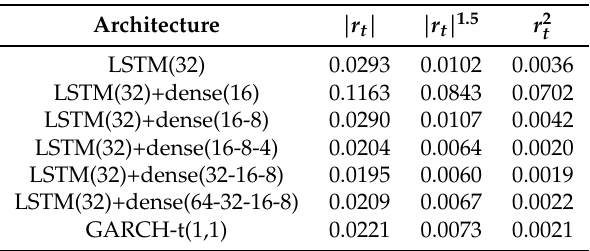
Table 2. Out-of-sample mean absolute errors (MAE) evaluated between 2 March 2018 and 28 February 2020. To evaluate the performances of models, we computed MAE for | r t | , | r t | 1.5 , and r 2 the better the performance